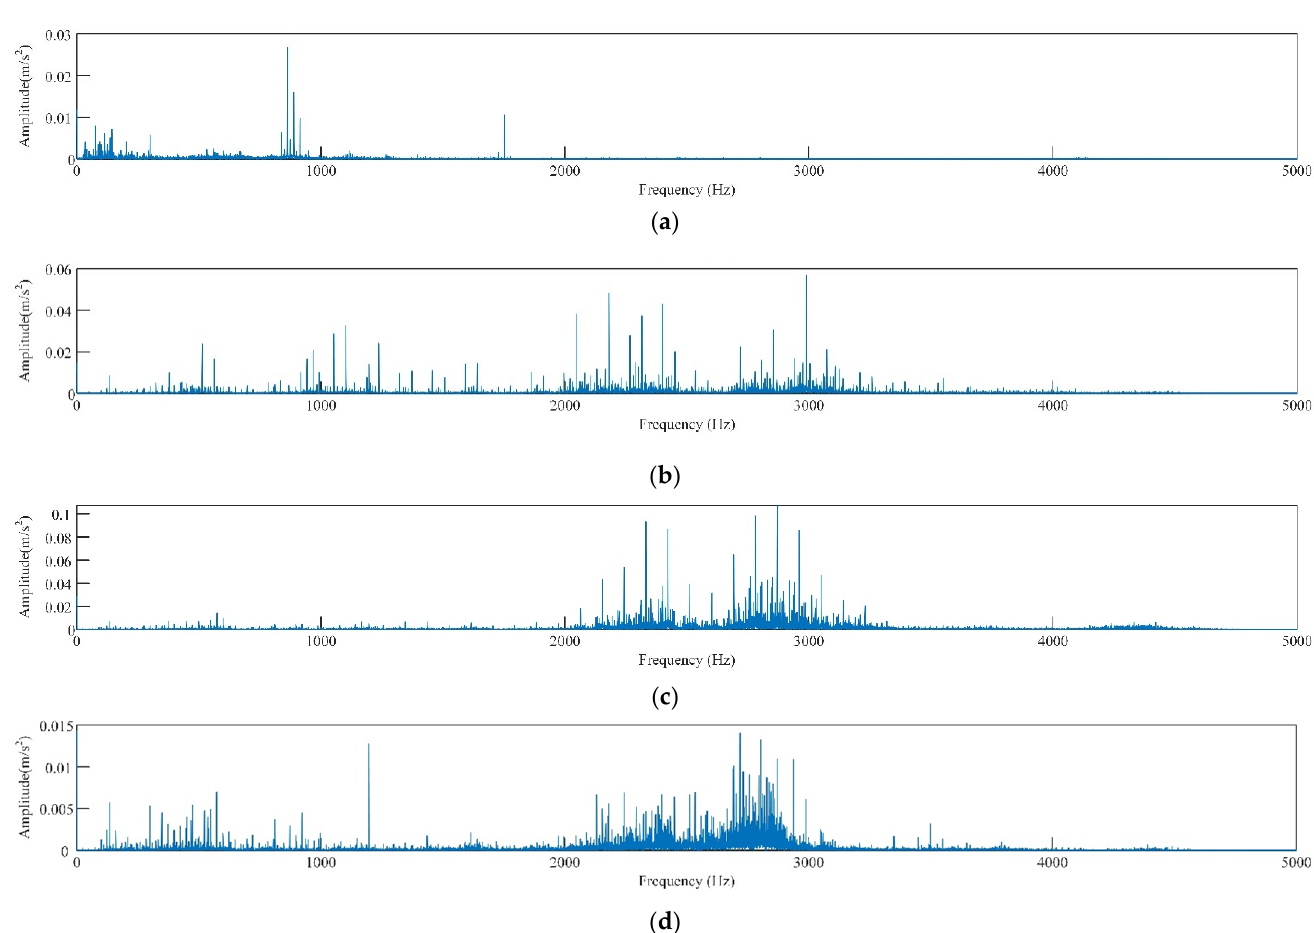
Figure 6. Frequency domain diagram of vibration signal of rolling bearing with inner ring fault under different loads, ( a ) 0HP, ( b ) 1HP, ( c ) 2HP.